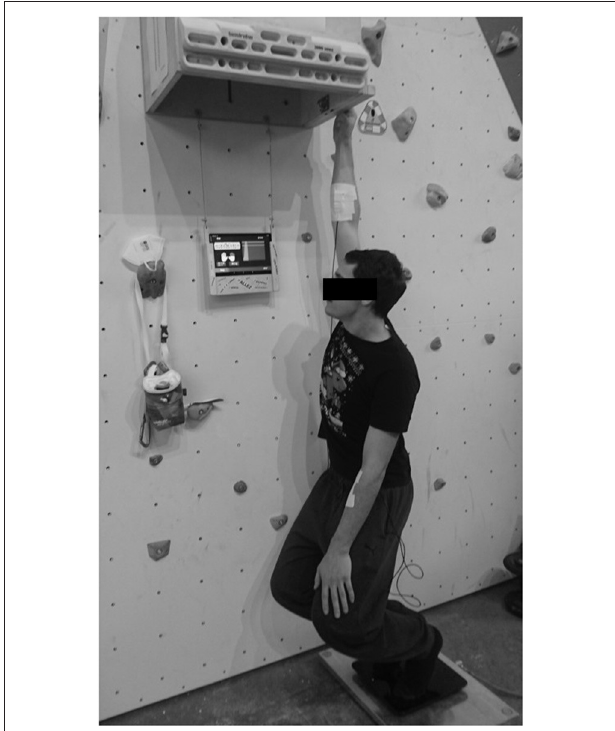
FIGURE 1 | Test setup. Participant standing on Entralpi © force plate, tablet for visual control at head height, one-hand pull on 23-mm